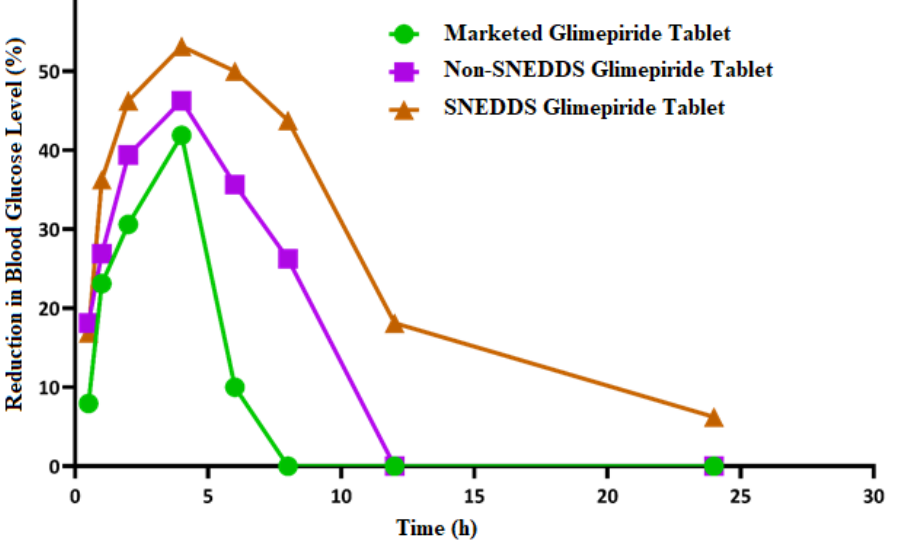
Figure 10. Inhibition of blood glucose (%) after oral administration of the SNEDDS, non-SNEDDS, and marketed glimepiride tablets to induced-hyperglycemic male Wistar rats ( n = 6).